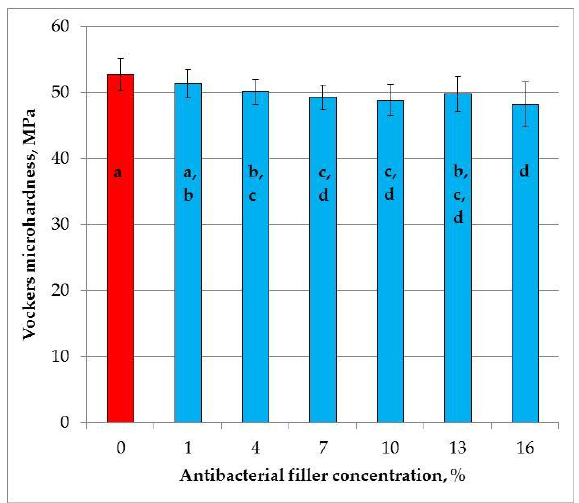
Figure 6. Mean Vickers microhardness values with standard deviations; different lowercase letters show significantly different results at the p < 0.05 level.